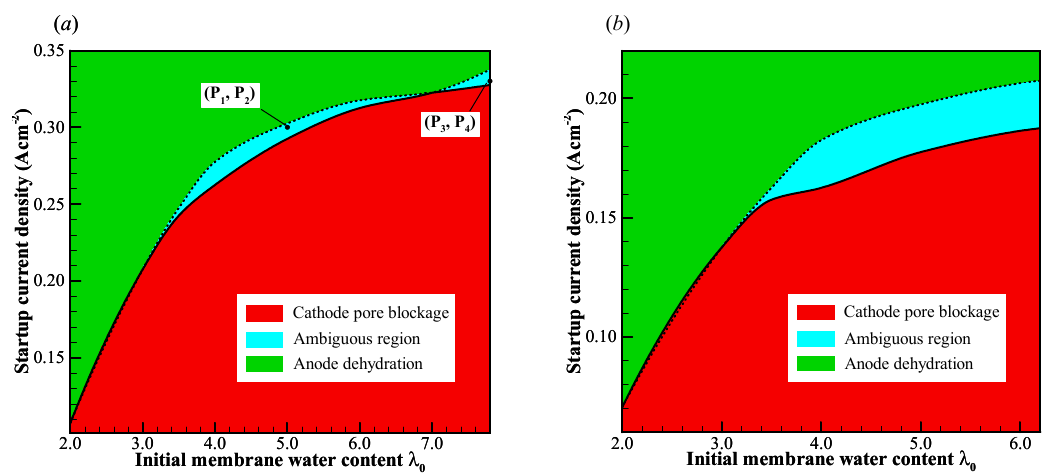
Figure 7. The map of failure modes for the cell starts from ( a ) − 20 °C and ( b ) − 30 °C. The cell is supplied with dry hydrogen and oxygen. The stoichiometry ratio of the mass flow rate is 2.0 for both anode and cathode sides. The background pressure is 1.0 atm at both the anode and cathode outlets.